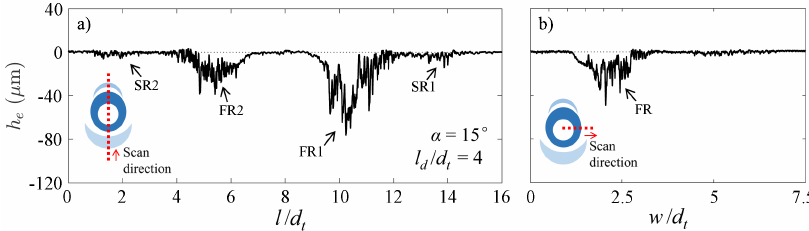
Figure 9. Profiles of the erosion at α = 15 ◦ . ( a ) longitudinal section at l d / d t = 4; ( b ) transverse section.